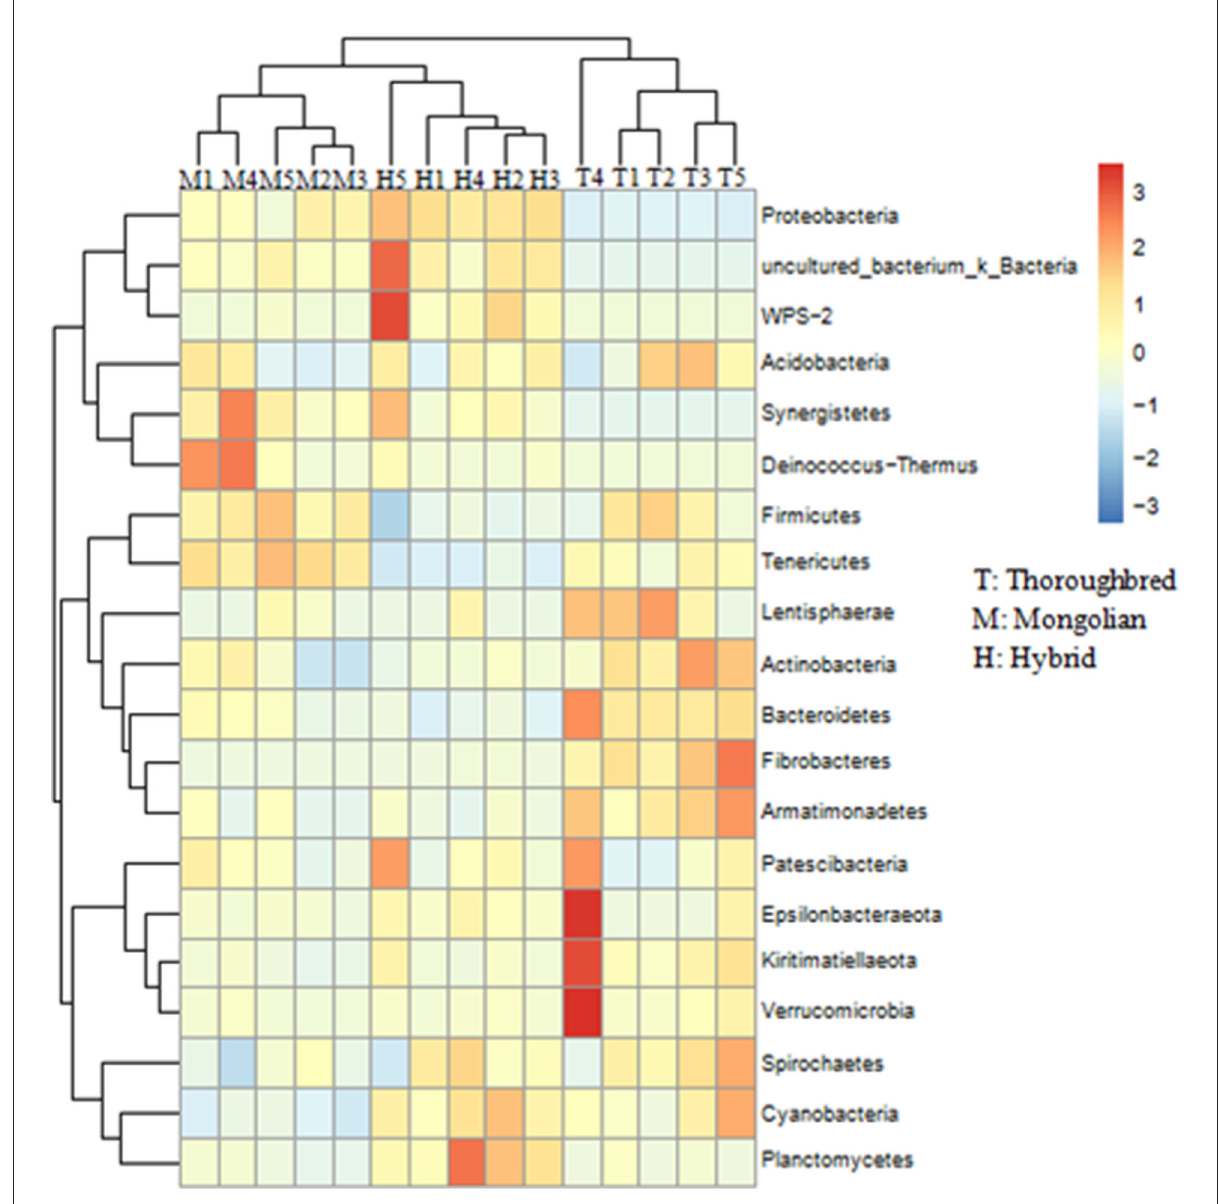
FIGURE5 Heatmap of species abundance clustering at the phylum level. T, Thoroughbred horses; M, Mongolian horses; H, Hybrid horses.